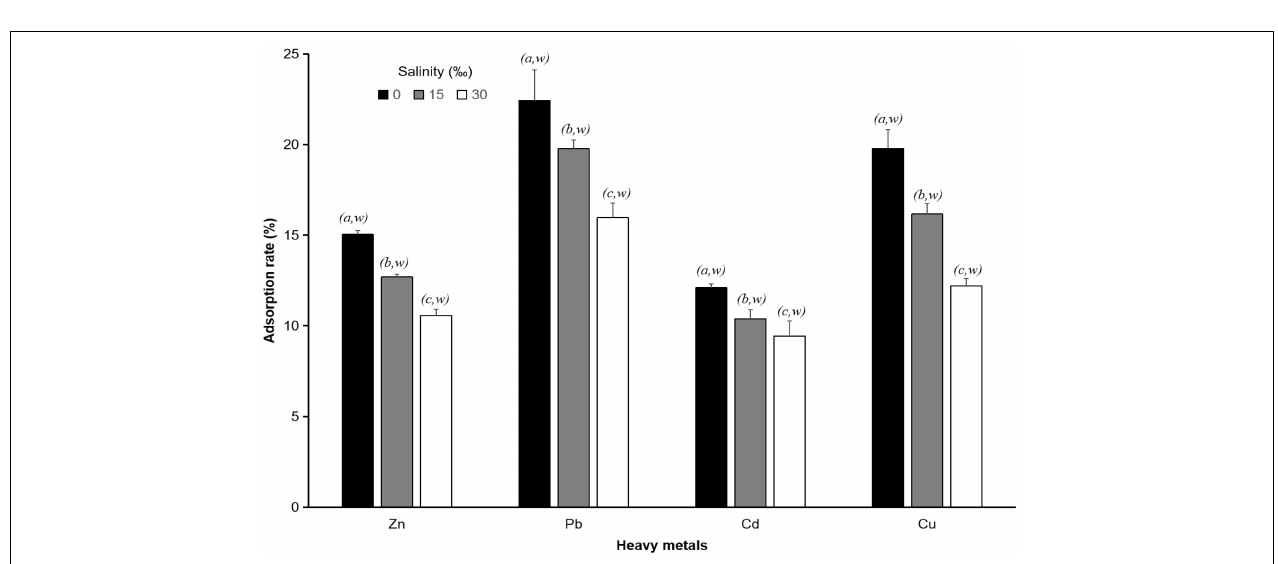
FIGURE 4 | Heavy metal (Zn, Pb, Cu, and Cd) equilibrium adsorption rate of 250 µ m PS with a 1 mg L − 1 heavy metal concentration and different salinities (0, 15, 30 ). Data for the adsorption rate (%) of the same heavy metal with different letters (a, b, c, and d) are significantly different ( p < 0.05) between each heavy metal and each salinity. (cid:104)